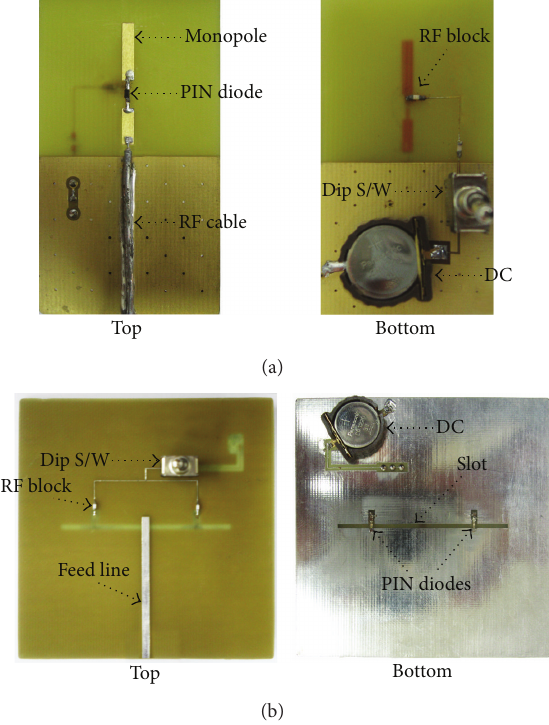
Figure 8: Photograph of the reconfigurable antennas with PIN diodes; (a) the monopole antenna and (b) the slot